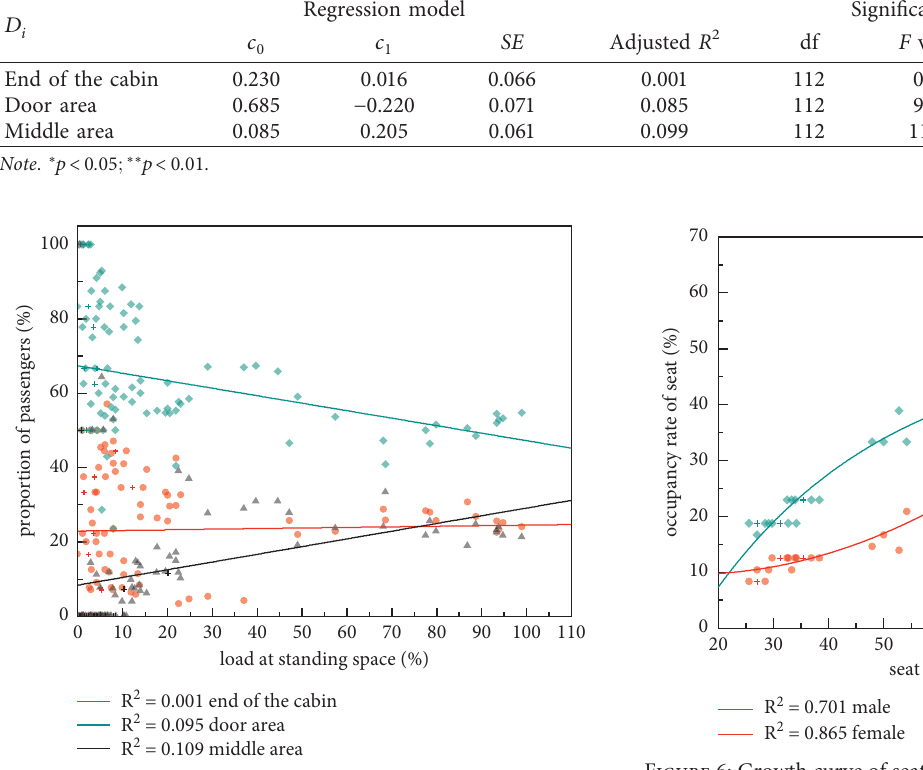
Figure 5: Changes in the proportion of passengers in the area.